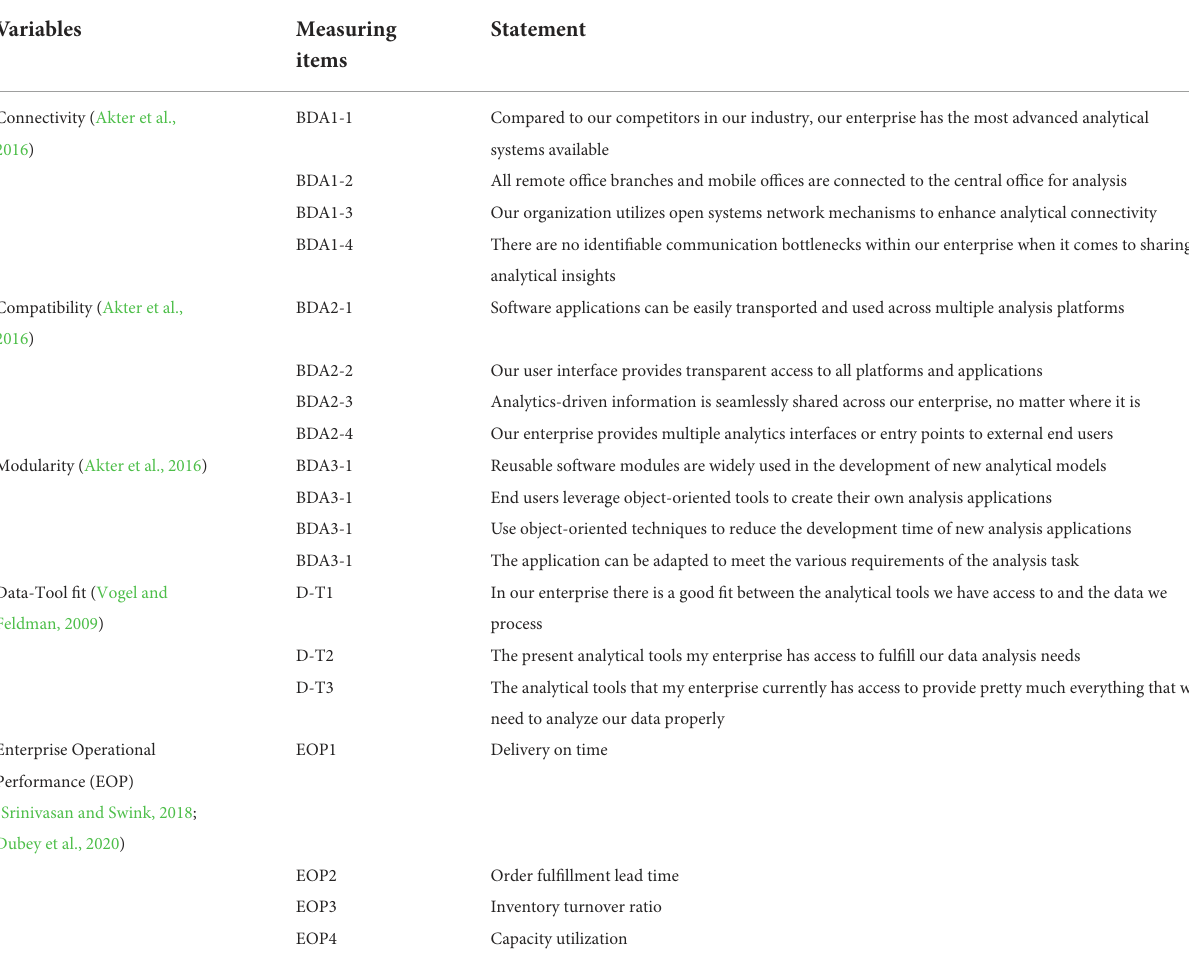
TABLE 2 Variables and measuring